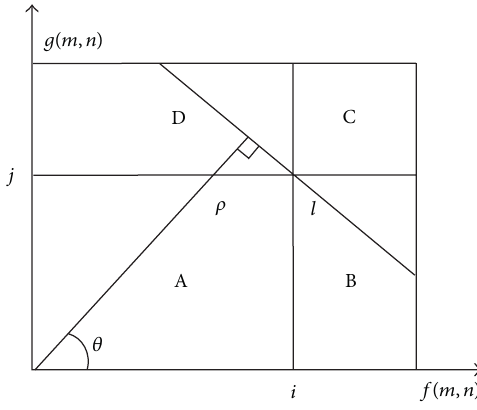
Figure 1: The 2D histogram with 𝜃